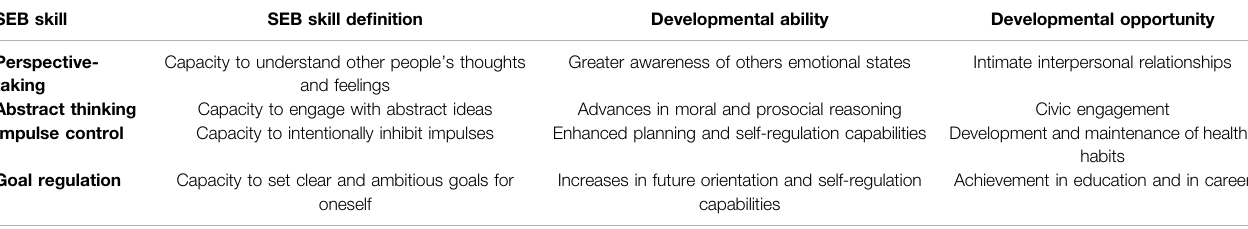
TABLE 2 | SEB skills in relation to new adolescent developmental abilities and